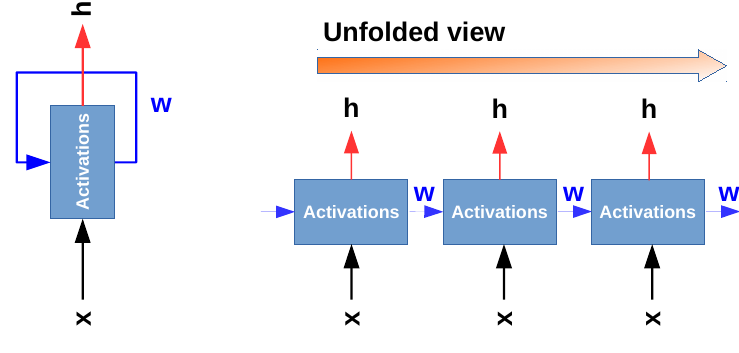
Figure 2. This figure illustrates the information flow in a recurrent neural network (RNN). The left image shows an RNN as an infinite loop network where the model outputs are fed back as inputs. The right figure is an unfolded representation of an RNN